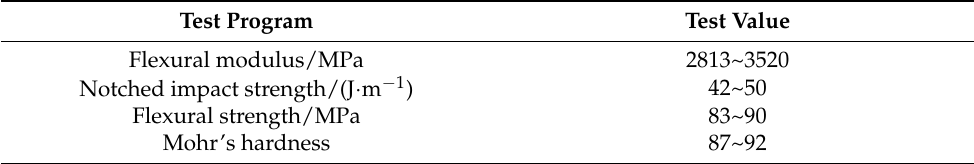
Table 3. Properties of photosensitive resin.